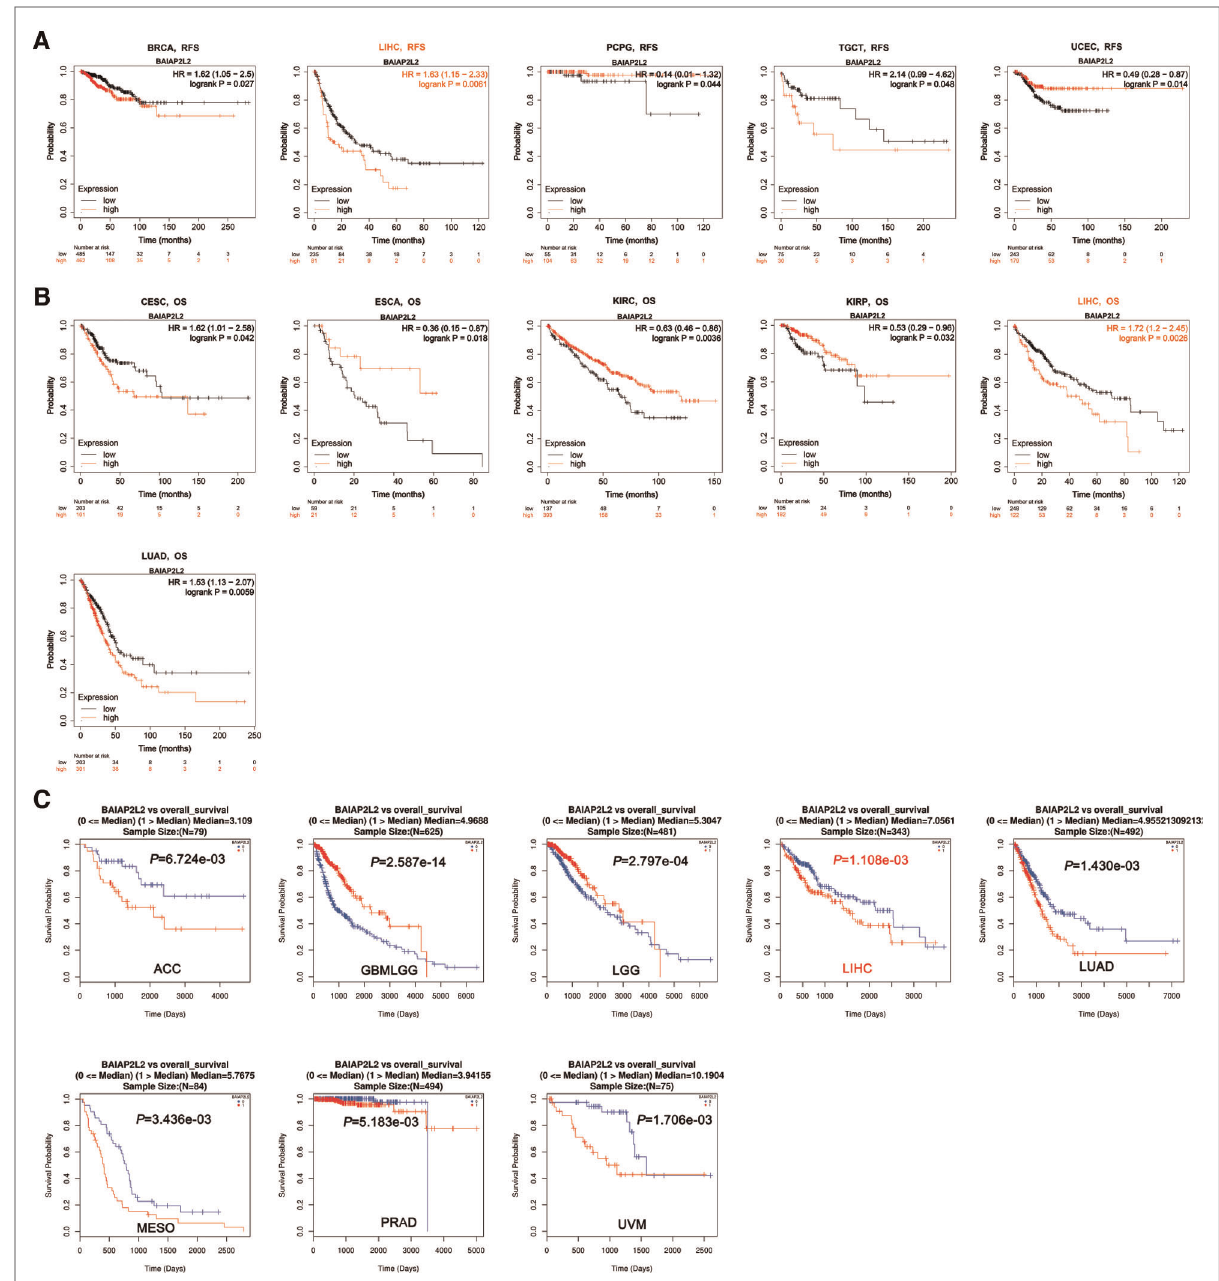
FIGURE 2 Survival analyses of BAIAP2L2 expression in different types of cancer. ( A ) Survival analysis of RFS in Kaplan – Meier plotter. ( B ) The survival analysis of OS in Kaplan – Meier plotter. ( C ) The survival analysis of OS From